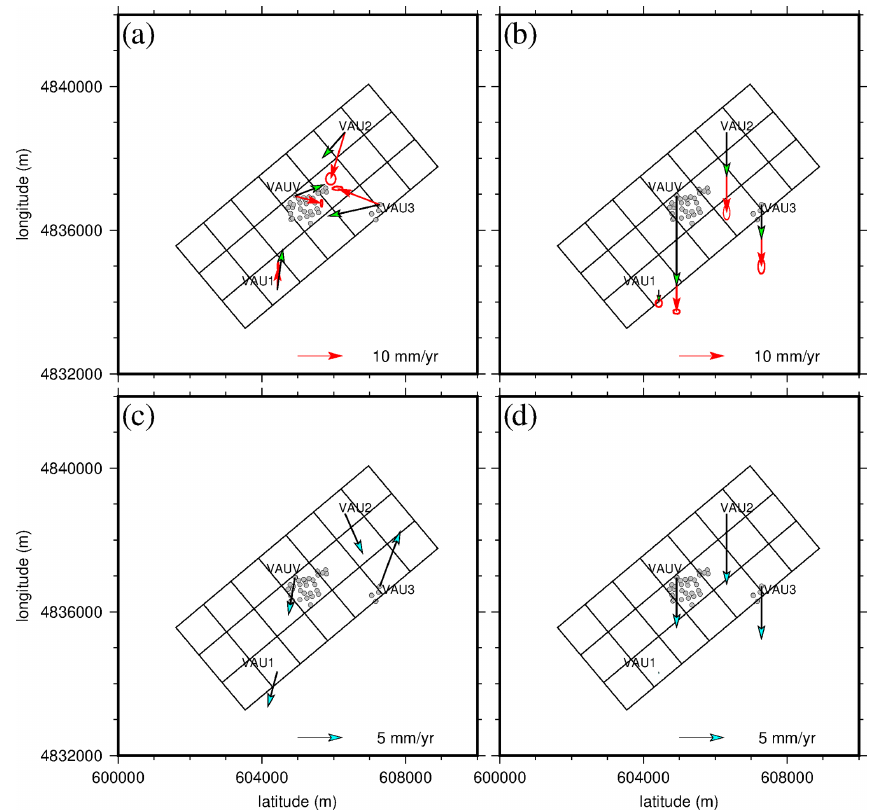
Figure 13. (a) Horizontal and (b) vertical velocities at the four permanent GNSS stations. Red arrows stand for the observed data and their 2 σ uncertainties and green ones for the modeled velocities using optimal parameters. Panels (c) and (d) represent the associated residuals. Note the change in arrow scale compared to (a) and (b)